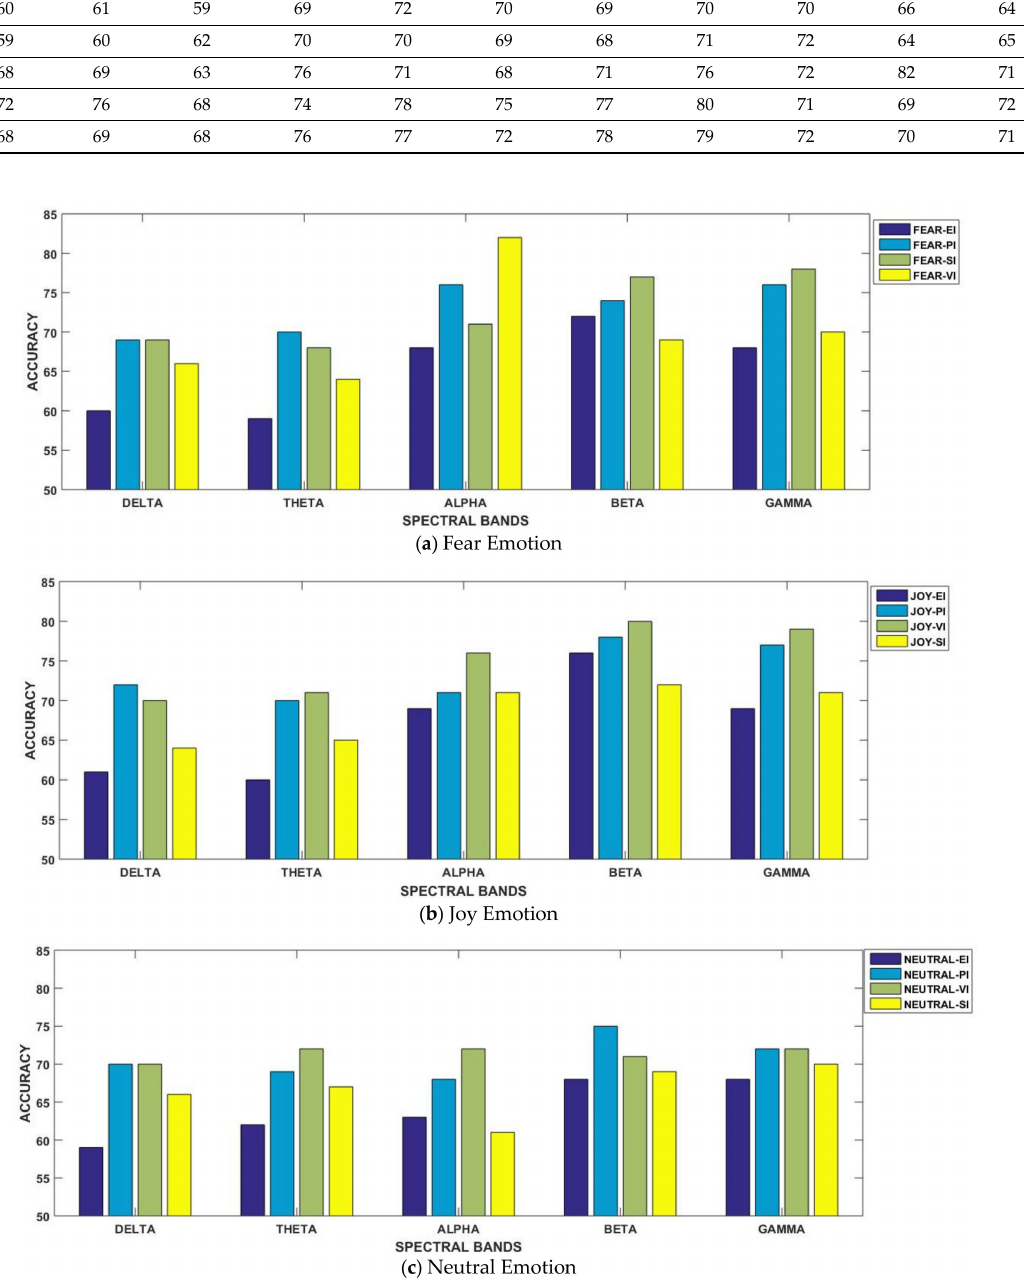
Table 3. Mean classification accuracies for all considered frequency bands in each of the four considered emotion-evoking paradigms. Paradigm EI PI VI SI Emotional State/ Fear vs. Happy Neutral Fear vs. Happy Neutral Fear vs. Happy Neutral Fear vs. Happy Neutral Spectral Rest vs. Rest vs. Rest Rest vs. Rest vs. Rest Rest vs. Rest vs. Rest Rest vs. Rest vs. Rest Band